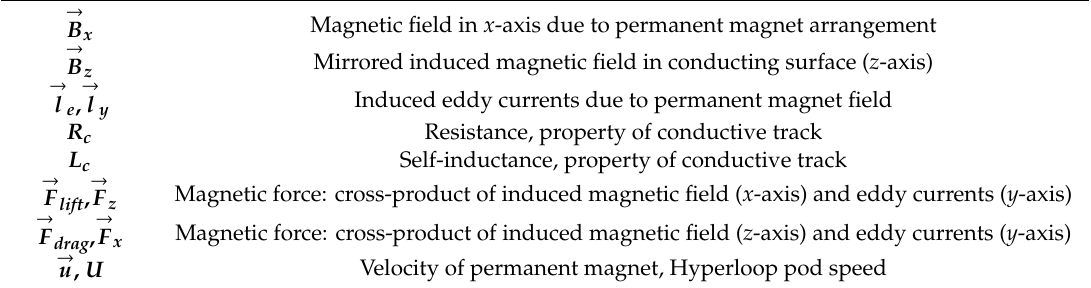
Table 1. Vectors and parameters of the passive maglev suspension